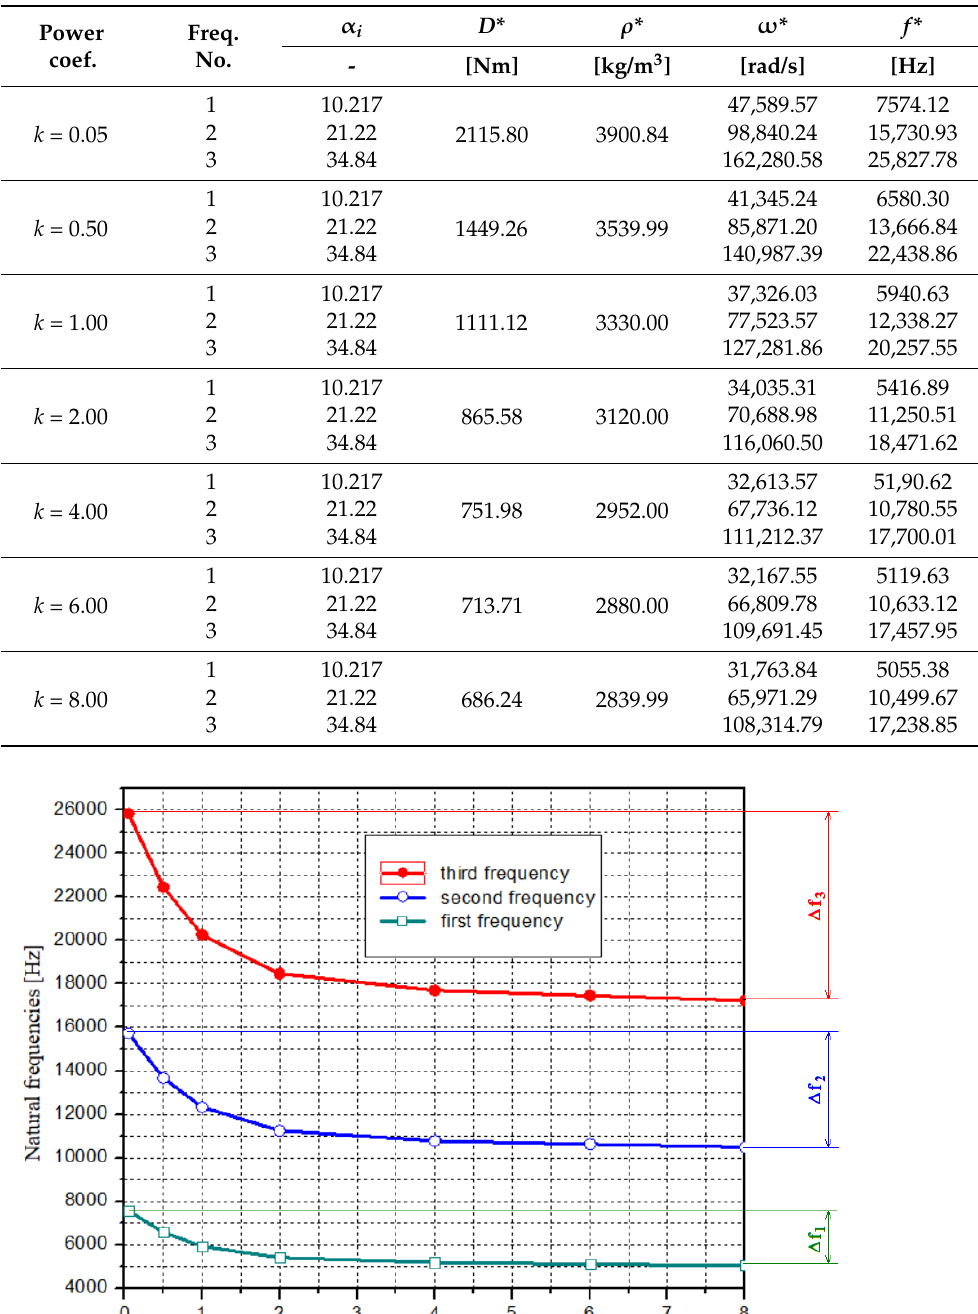
Table 11. Some results of natural frequencies by analytical calculus.